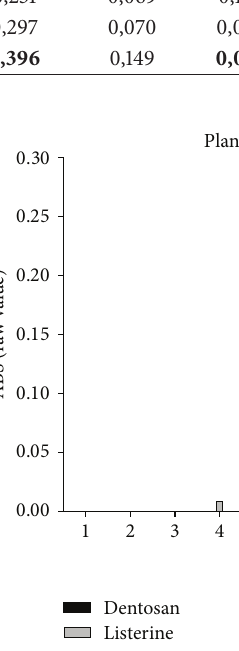
Figure 1: Comparison between absolute values of absorbance related to the PG of Aa when exposed to growing dilution (from 1/2 to 1/2048) of the tested